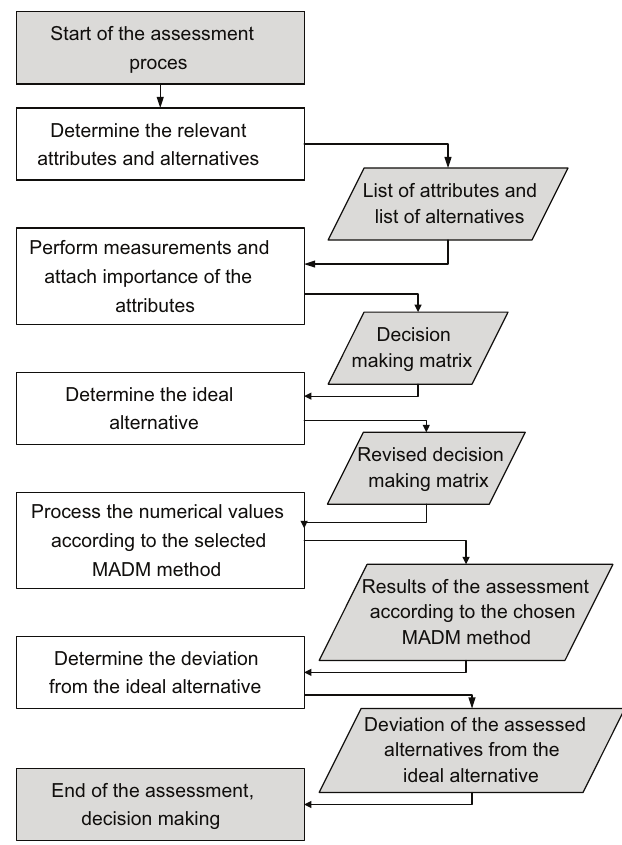
Figure 1. the schema of the multi-attribute assessment using ideal alternative (a white rectangular presents a step of the assessment (process), a grey rectangular – start and/or end of the assessment, a parallelogram – input and/or output of a